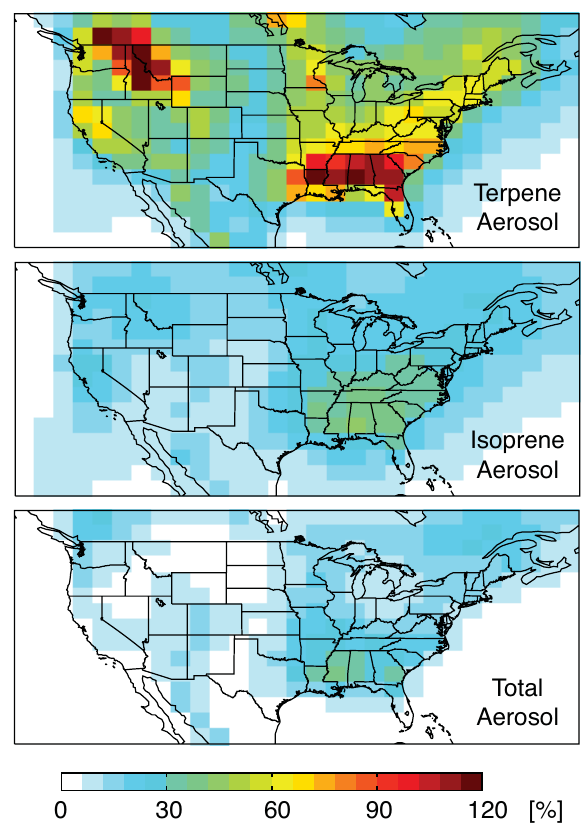
Fig. 7. Enhancement in surface-level August 2000 aerosol from ter- penes (monoterpenes and sesquiterpenes), isoprene, and all sources due to aerosol from the nitrate oxidation pathway. The change is relative to a simulation with yields set to zero for the nitrate oxida- tion pathway. POA is assumed to be non-volatile and IVOCs do not form aerosol (traditional